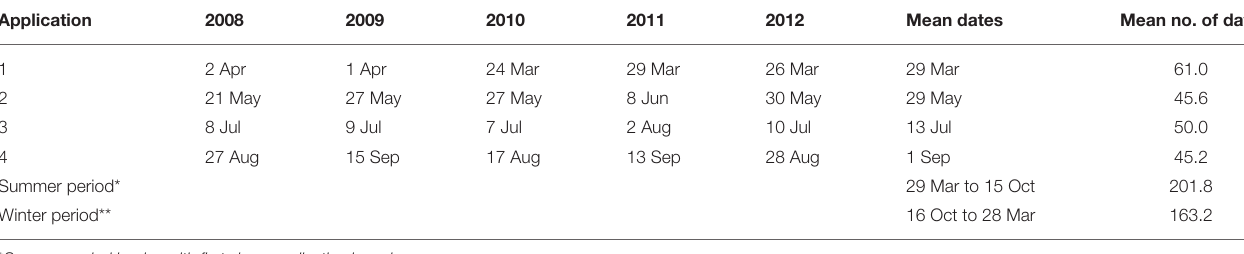
TABLE 1 | Dates of slurry applications on forage grass and mean number of days from an application to next application. Application